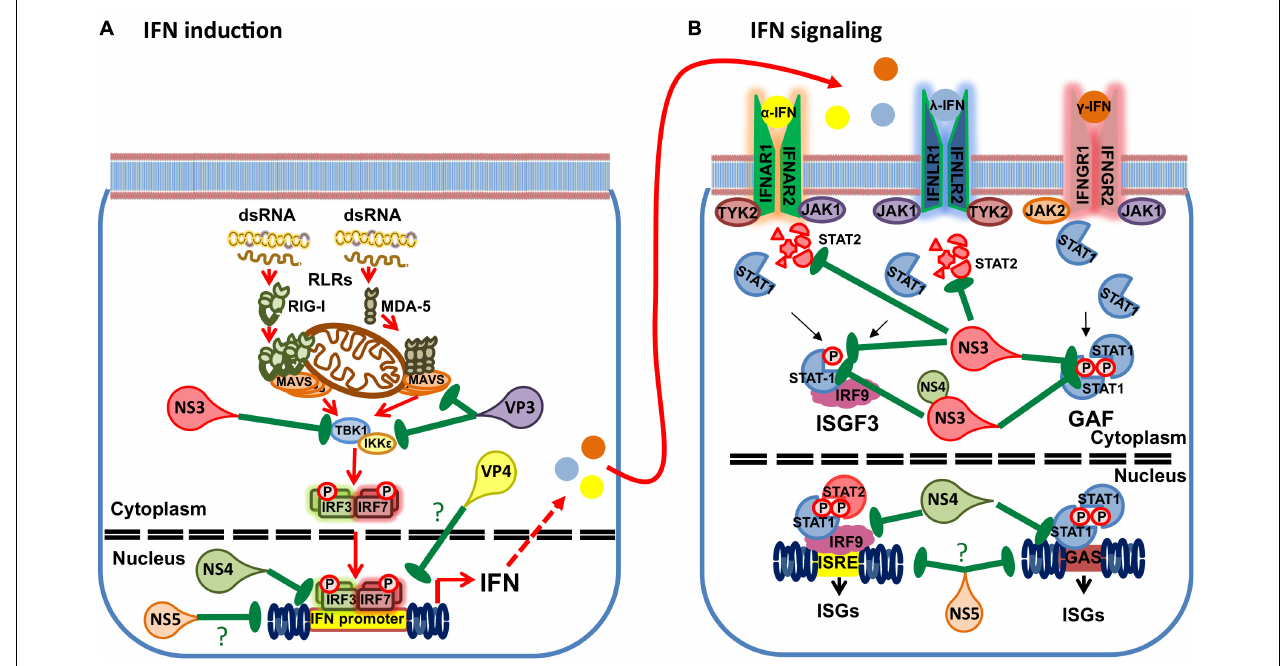
FIGURE 4 | Interference of BTV gene products with the IFN response. (A) BTV uses multiple gene products to impair IFN induction. NS3 has been shown to impair TBK1 activation by targeting the ubiquitin-binding protein Optineurin responsible for TBK1 translocation to the Golgi apparatus, where TBK1 activation by trans-autophosphorylation takes places. NS4 has been shown to impair IFN promoter gene activity in reporter assays. VP3 has been shown to interact with MAVS and IKK ε to interfere with IFN induction. VP4 has been reported to interfere with IFN induction, but the mechanism has yet to be clarified. Finally the putative NS5 has been shown to interfere with the activity of multiple promoters including the IFN- β promoter. (B) BTV also uses multiple gene products to interfere with IFN signaling. NS3 can target STAT2 for degradation through an autophagic/lysosomal pathway. NS3 can also interfere with STAT1 phosphorylation. NS4 and NS3 appear to coordinately impair STAT1 phosphorylation by binding to STAT1 SH2 domain. NS4 can also interfere with the ISRE and GAS promoter activity. Finally, the putative NS5 can impair the activity of multiple promoters and thus possibly impair ISRE and GAS promoter activity. (?) denotes unknown or speculative